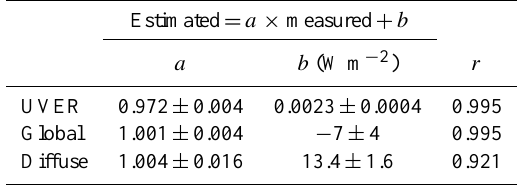
Table 2. Estimation of solar UVER, global and diffuse irradiance values by means of linear regressions for clear-sky conditions in Marsaxlokk, Malta in the period August to October